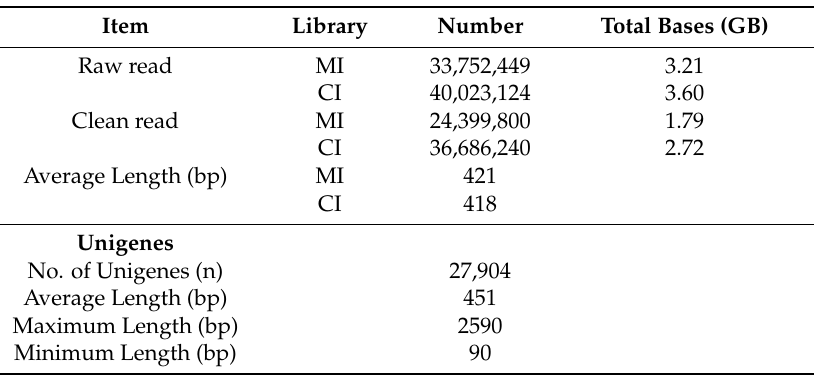
Table 1. Statistics of RNA-seq analysis in mock-inoculated (MI), CBCVd-infected libraries (CI), and assembly for